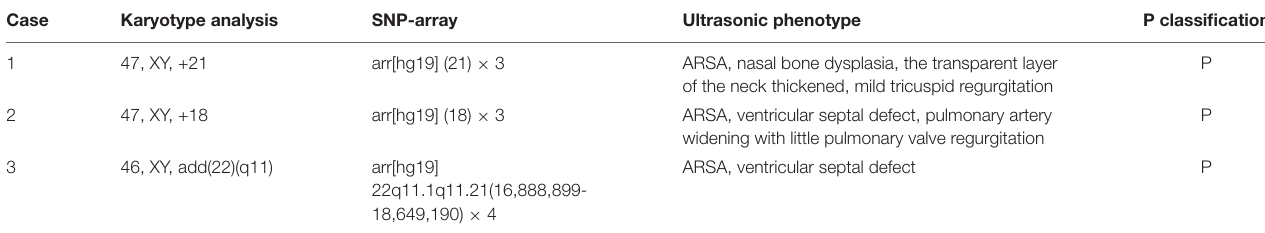
TABLE 2 | Karyotype analysis detected in fetuses with ARSA.